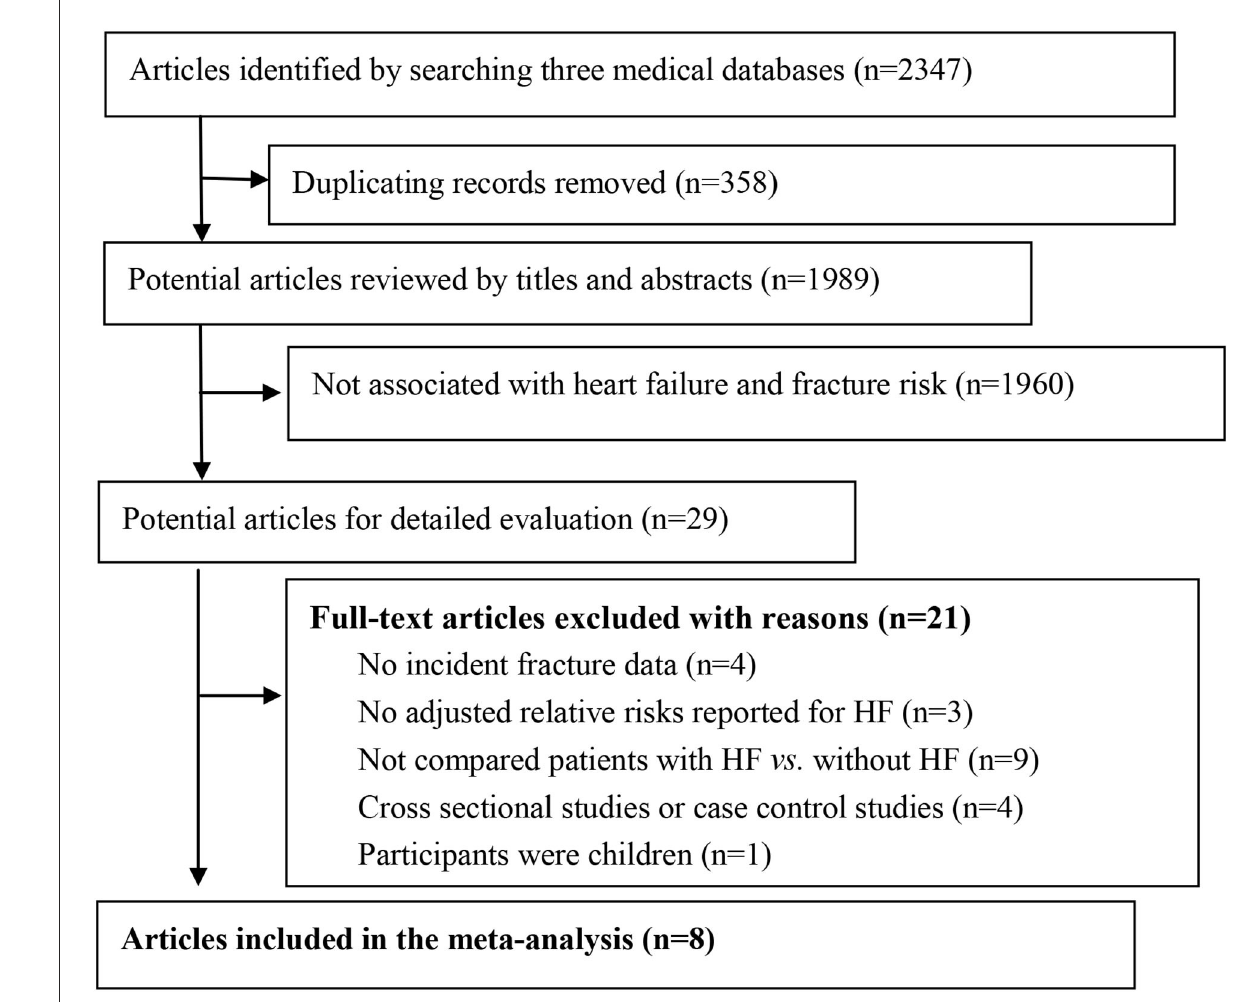
FIGURE1 Flow of studies selection for